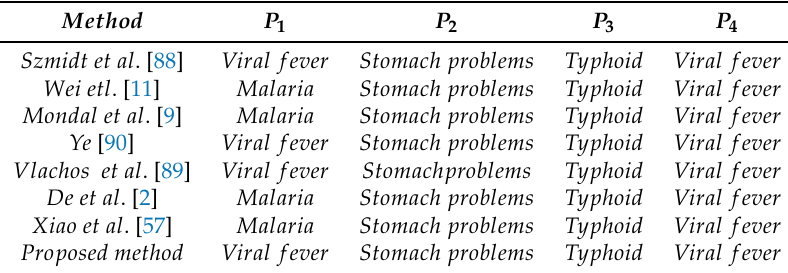
Table 14. The results generated by other